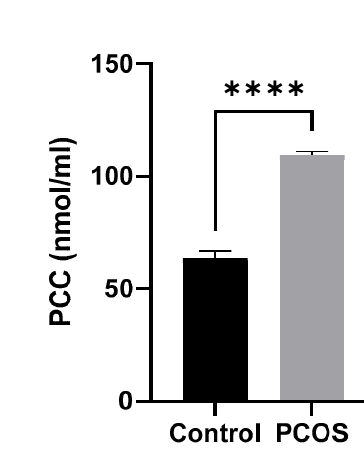
Figure 4. Serum LPO and PCC are elevated in PCOS patients. Means ± SEM of ( a ) LPO and ( b ) PCC levels. **** p < 0.0001.